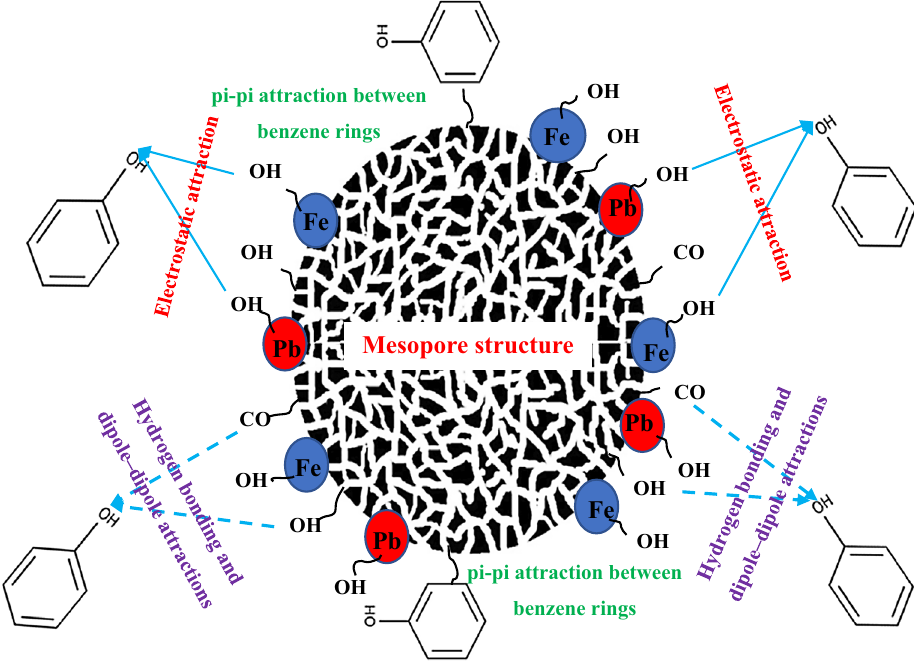
Figure 13. Proposed mechanism for phenol adsorption onto MSAC composite.